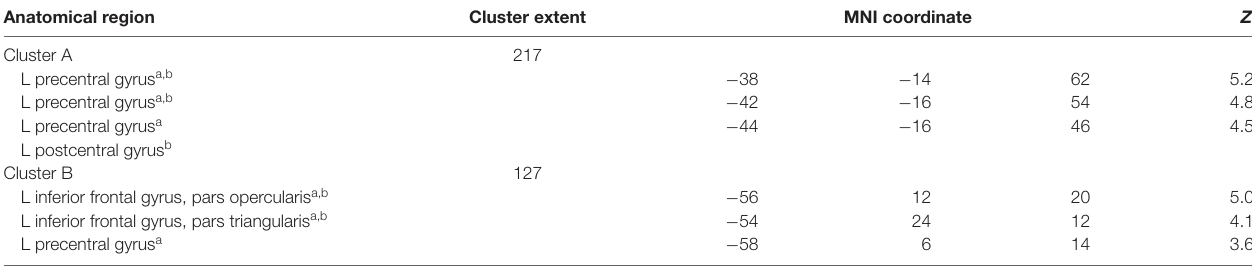
TABLE 1 | fMRI results for the interaction of session and group in the AO+MI condition. Anatomical region